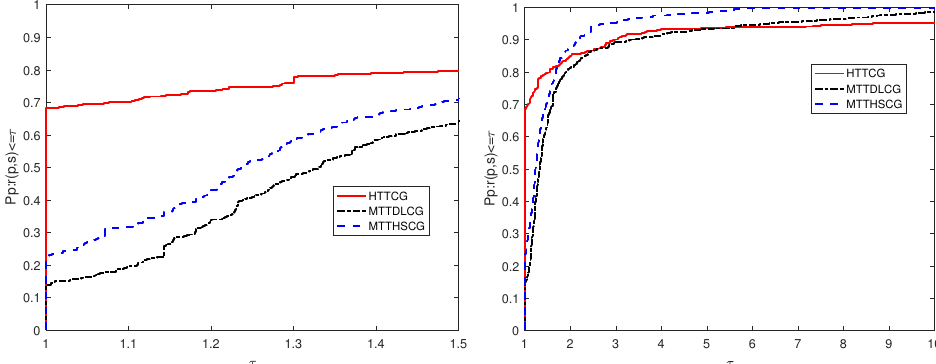
Figure 2. Performance profiles of the numerical results for these methods in a number of function and gradient evaluations.